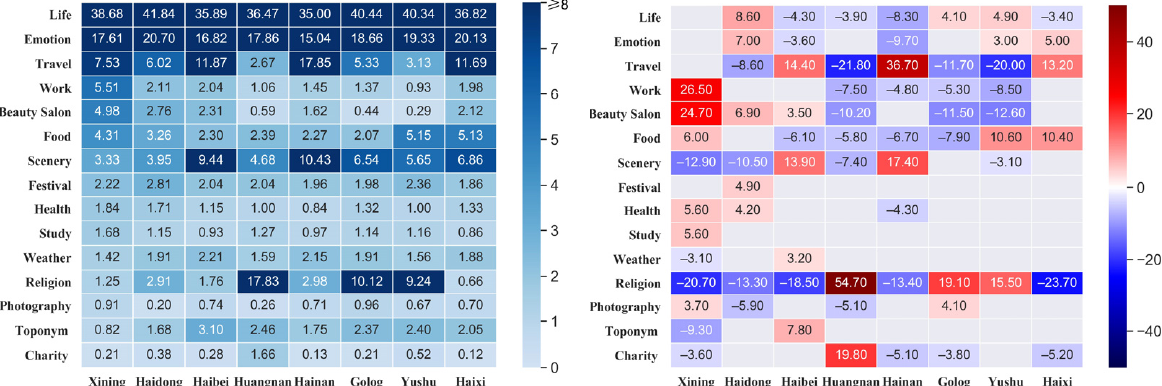
Figure 9. Distributions and adjusted standardized Chi-square residuals for the top 20 topics in the Qinghai resident dataset by city (unit: %).